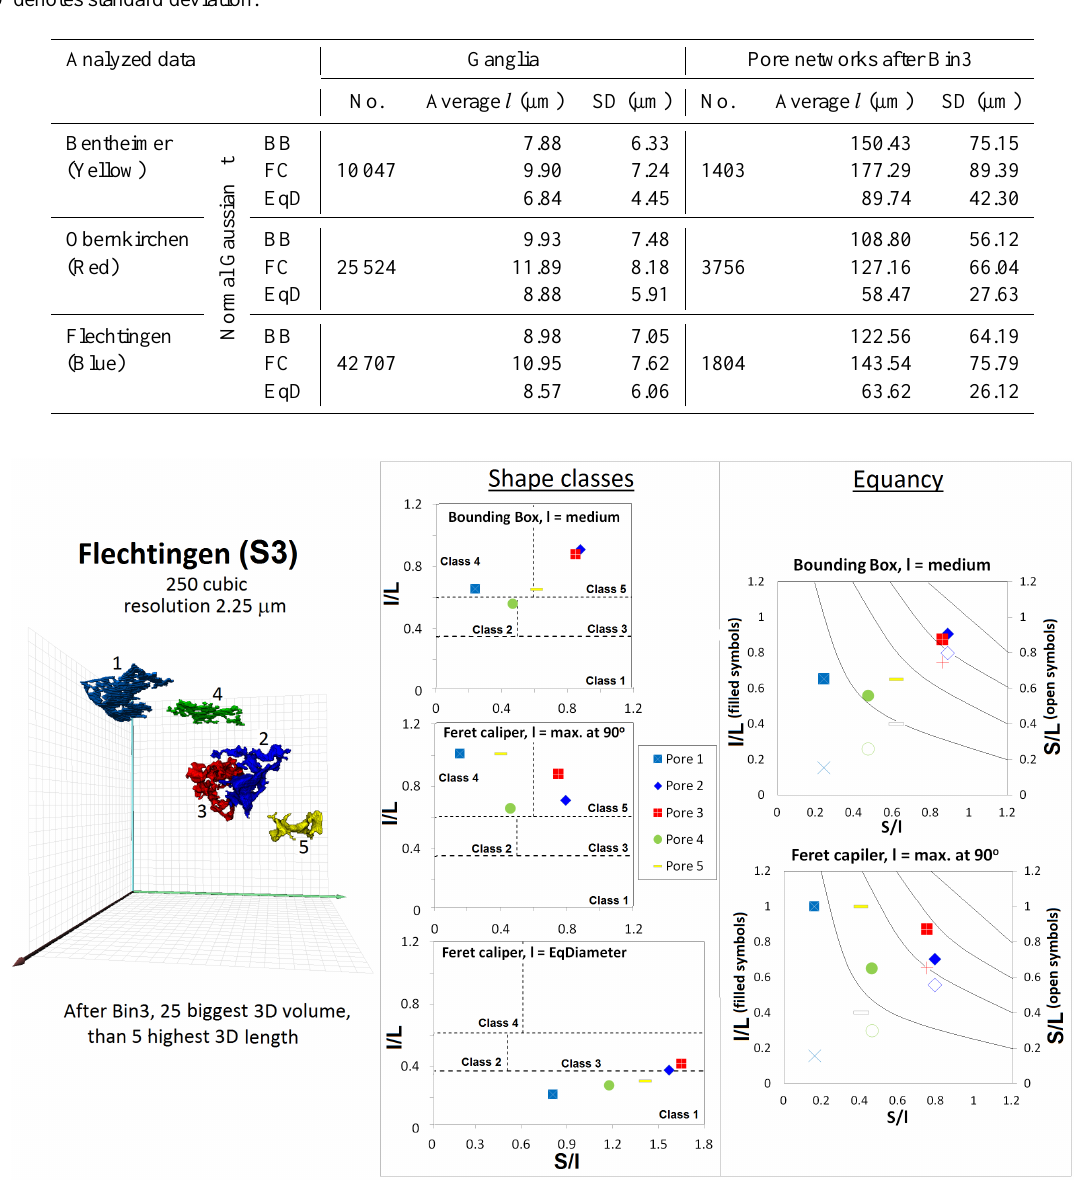
Table 3. Thickness statistics for the pore ganglia and detached pore networks after a normal Gaussian fit to the distribution data, shown in Fig. 6. SD denotes standard deviation.